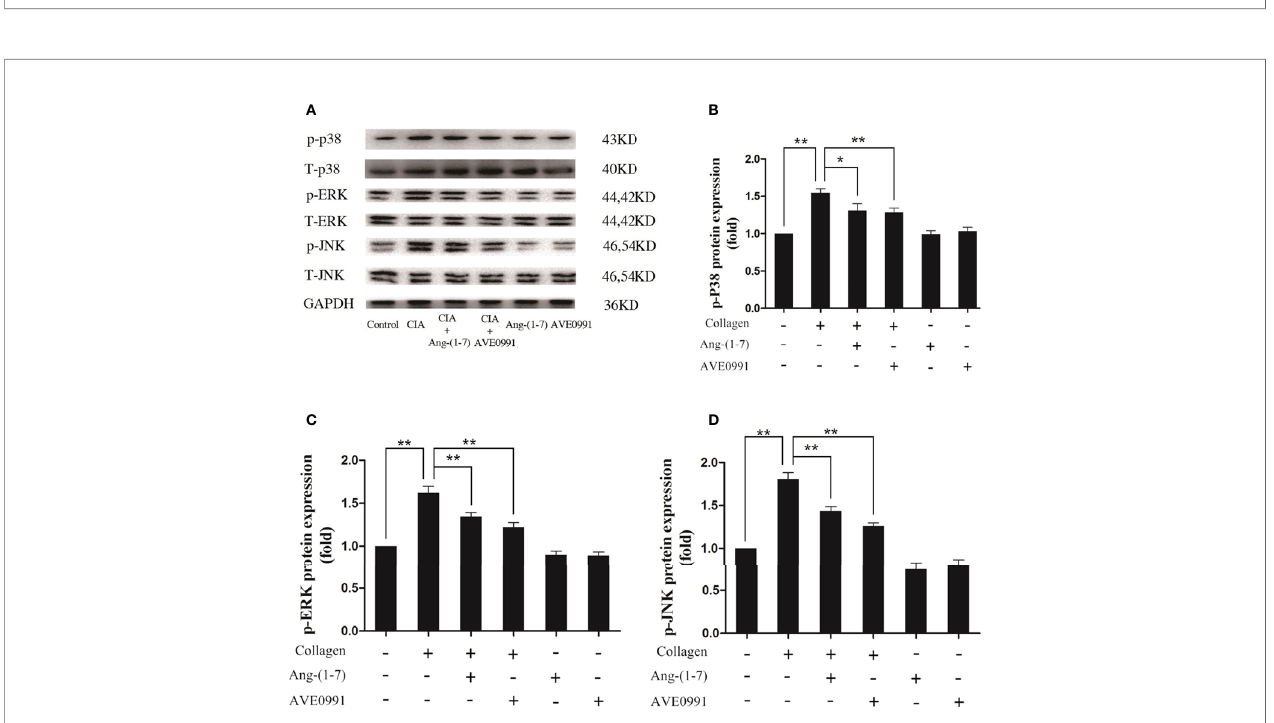
FIGURE 3 | Ang-(1 – 7) and AVE0991 inhibit arthritis-induced p-p38, p-ERK, and p-JNK expression in ankle. (A) Representative immunoblots for p-p38 、 p38 、 p-ERK 、 ERK 、 p-JNK, and JNK. (B) Representative quantitative analysis of p-p38. (C) Representative quantitative analysis of p-ERK. (D) Representative quantitative analysis of p-JNK. Values are expressed as means ± SD (n = 6). *P < 0.05,